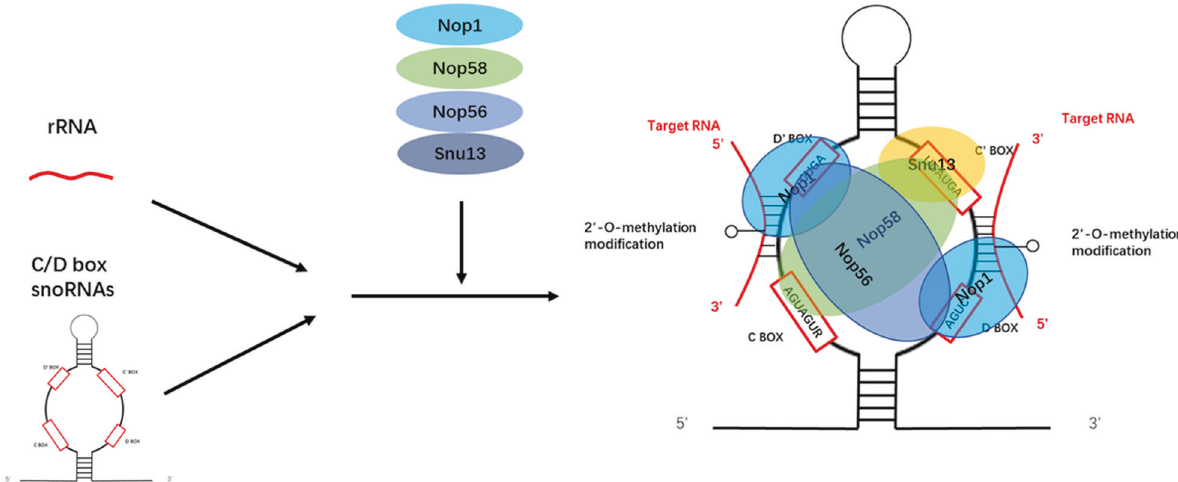
Fig. 4 C/D box snoRNPs modi fi e the target RNA by 2 ′ -O-methylation. SnoRNAs bind to target RNAs by antisense elements upstream of D box and/or D ’ box. SnoRNAs form functional snoRNPs by binding to four core proteins, including Nop1p, Nop56p, Nop58p, and Snu13p. Among them, Nop1p transfers the methyl group on s-adenosine-methionine to the 2 ′ - hydroxyl group of the target RNA ribose.